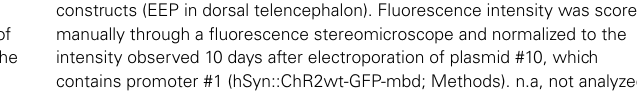
FIGURE 3 | Continued targeted electroporation using internal wire electrodes (IEP; z-projections of multiphoton image stacks). (G) Fluorescence intensity observed through the dorsal skull at different time points after electroporation of different